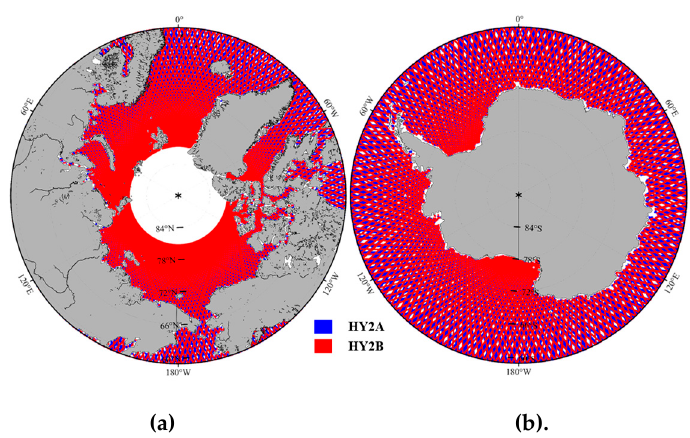
Figure 2. Spatial coverage of HY-2A/B in the polar regions in November of 2018: ( a ) Arctic; ( b ) Antarctic.